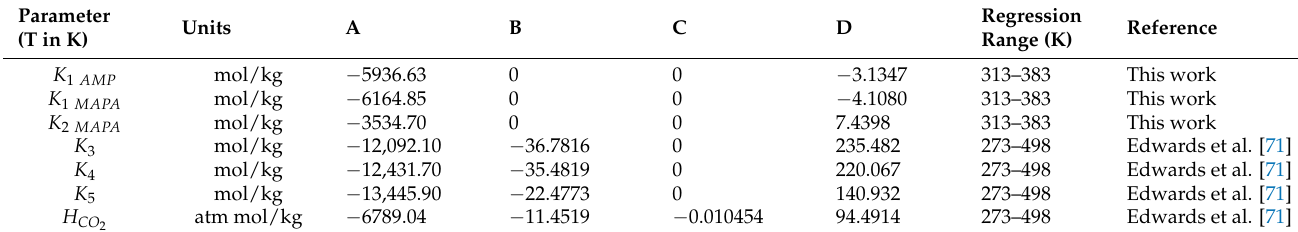
Table 12. Parameters of Equation (36) for AMP and MAPA aqueous